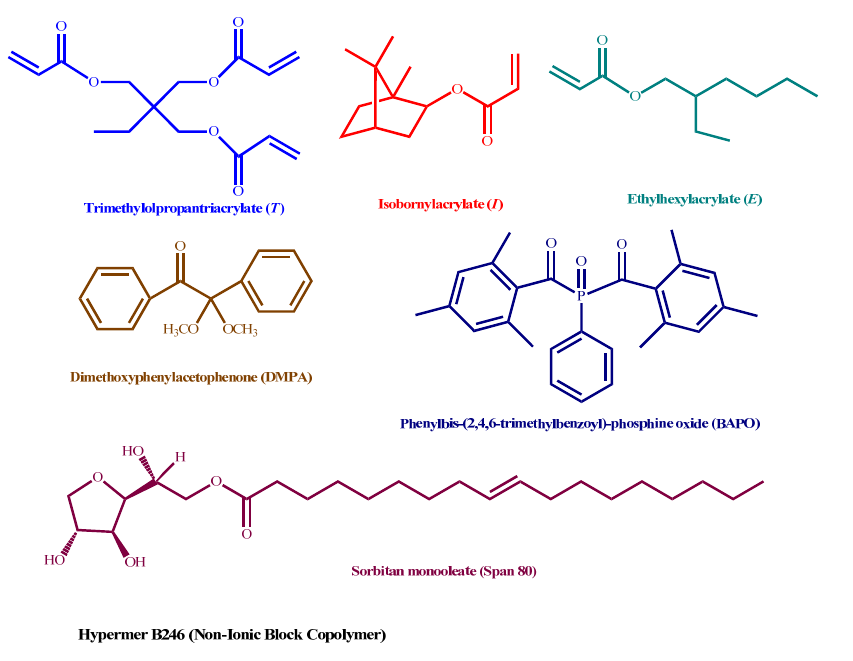
Figure 1. Chemical structures of the compounds used in this study.